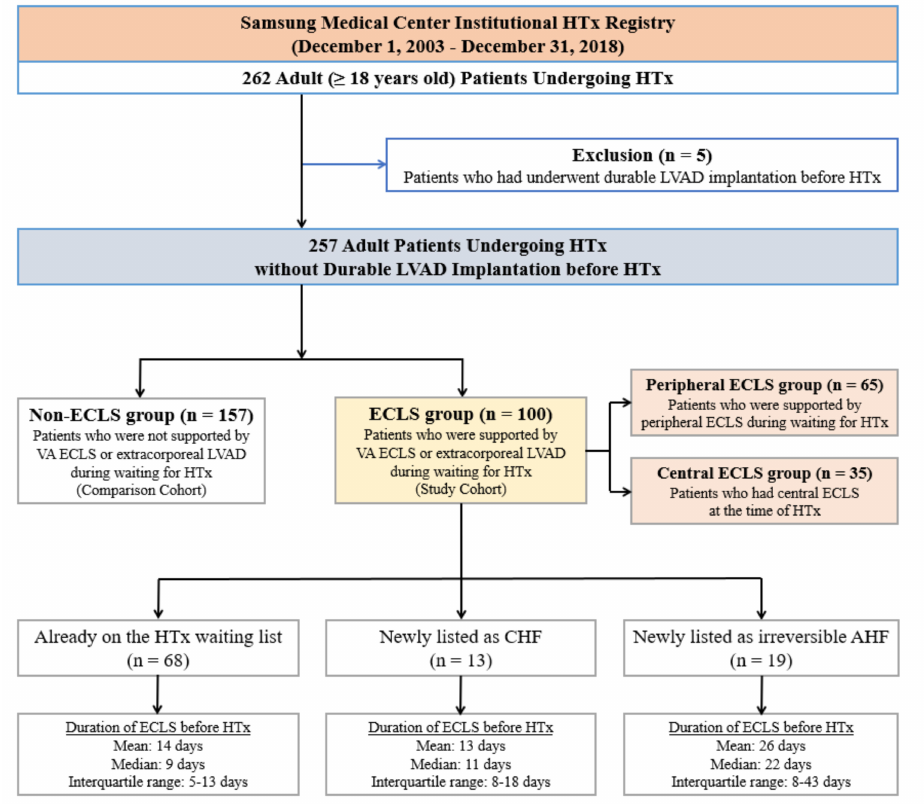
Figure 1. Flow diagram of patient recruitment. HTx, heart transplantation; LVAD, left ventricular assist device; ECLS, extracorporeal life support; VA, venoarterial; CHF, chronic heart failure; AHF, acute heart